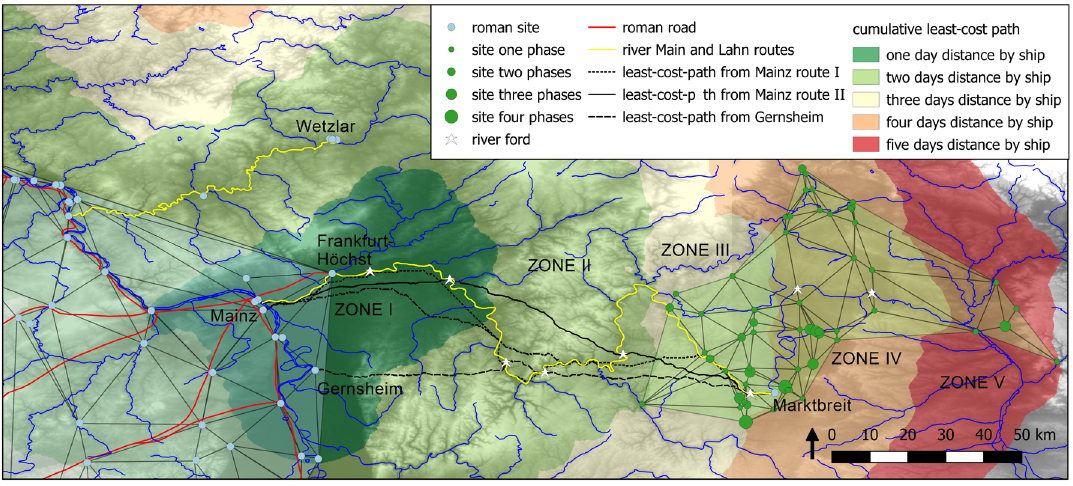
Figure 7. Roman point of view. Starting from the auxiliary fort at Frankfurt-Höchst, partly occupied by Germanic auxiliaries, Marktbreit lay just within the medium to well-accessible distance zone III. The five distance zones as equivalents of estimated travelling days by ship shown here display accessibility models calculated and visualized spatially in the GIS (GRASS) with cumulative least-cost path analyses from Frankfurt-Höchst (for method, see: Verhagen et al. 2013). Sources see: Fig. 3, GIS